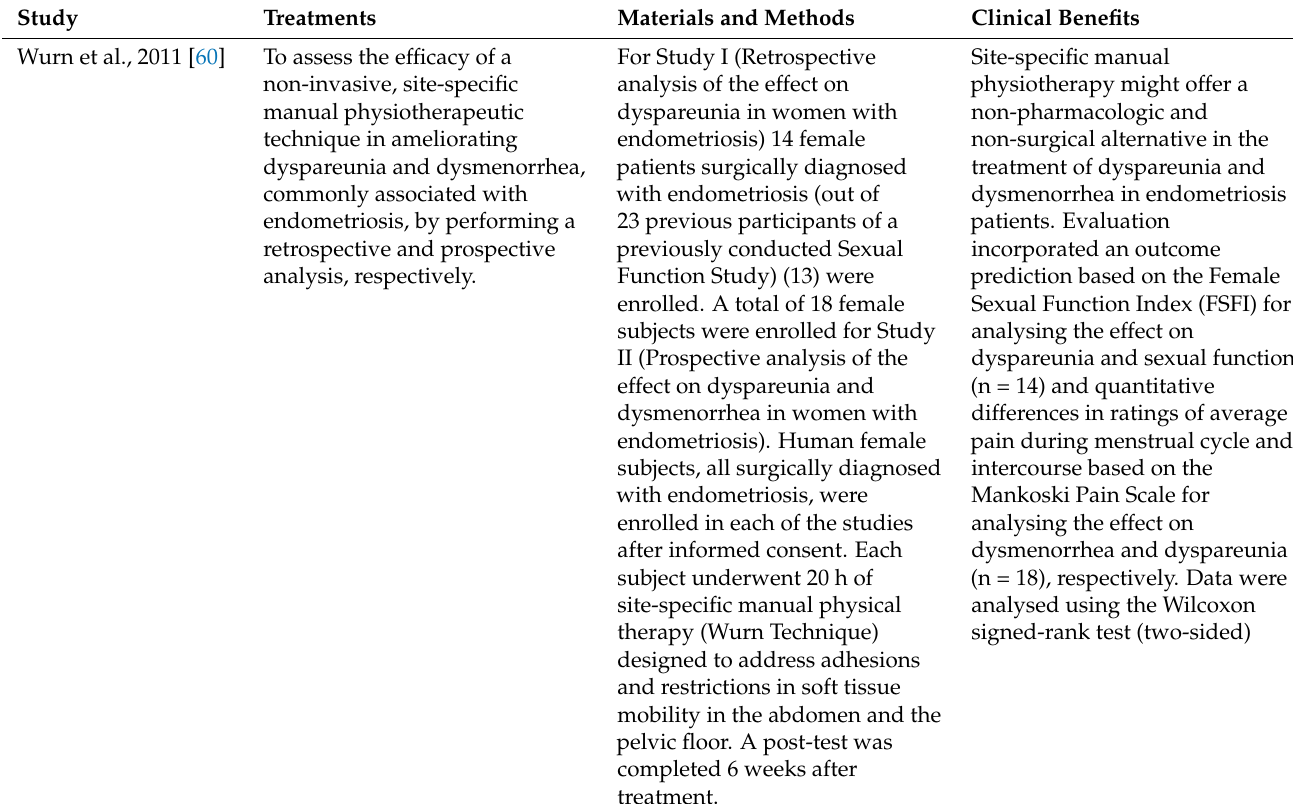
Table 2. Application of non-invasive site-specific manual physiotherapy